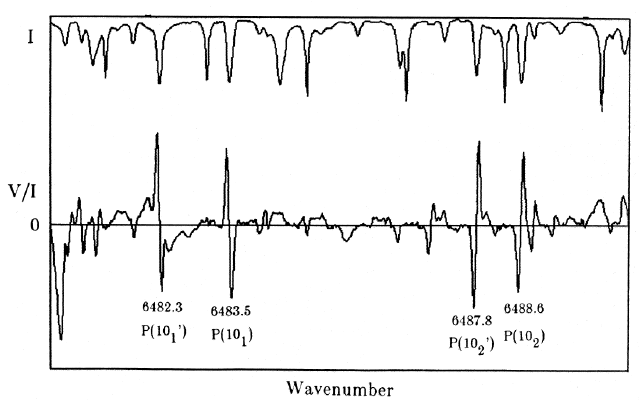
Figure 23: The Zeeman Stokes V splitting patterns for several molecular lines. Although the molecular lines measure the same magnetic field, the properties of the particular lines produce positive and negative polarity Stokes V profiles. Image reproduced with permission from Harvey (1985), copyright by